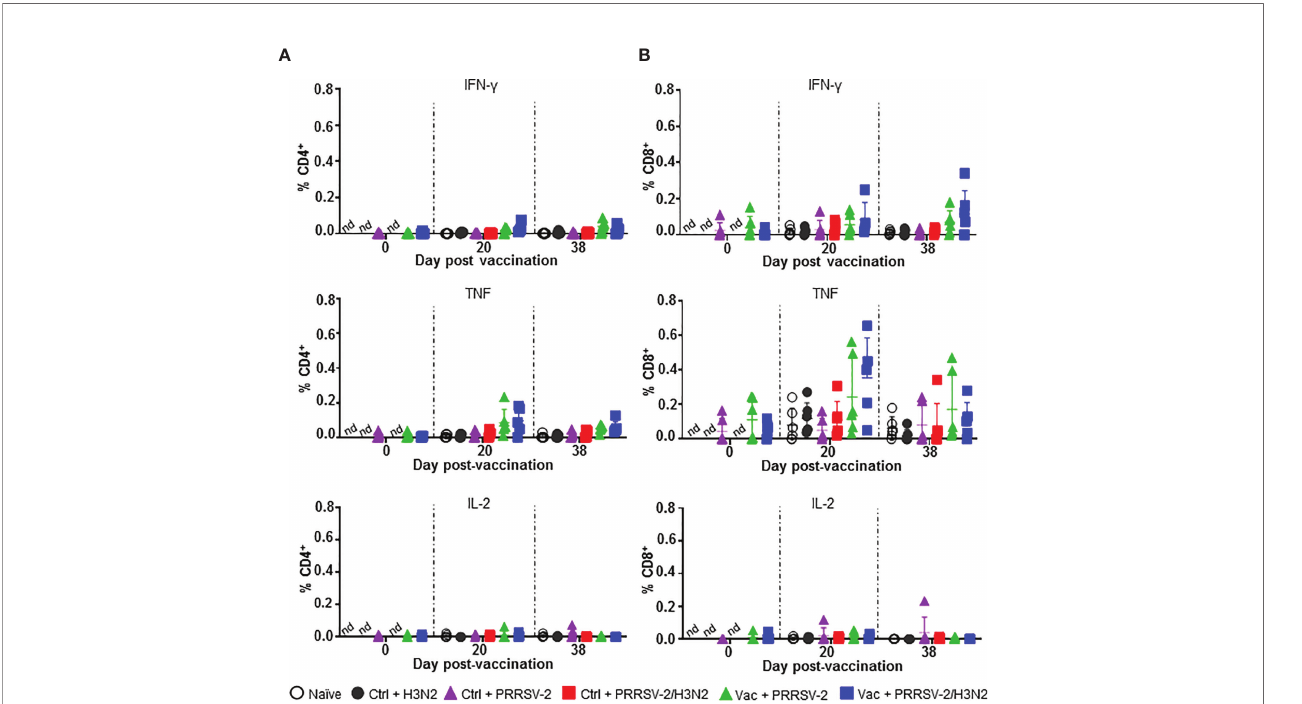
FIGURE 4 | PRRSV-2-speci fi c T cell responses in PBMC. PBMC isolated at 0, 20 and 38 dpv were restimulated in vitro for 18h with PRRSV-2 (MOI 0.1) or cultured with medium. Intracellular staining of IFN- g , TNF, IL-2, was performed and frequencies of IFN- g , TNF and IL-2 producing CD4 + (A) and CD8 b + (B) T cells were analyzed. The corrected frequencies values are shown (percentage of cytokine-producing cells subtracted with medium only). Data for individual pigs and the group mean ± SD are displayed (n = 5-6 per group). The Wilcoxon test was used to compare the T cell responses at day 0 and 20 dpv within the same group. Comparisons between 2 groups were performed using Mann-Whitney test. nd: not